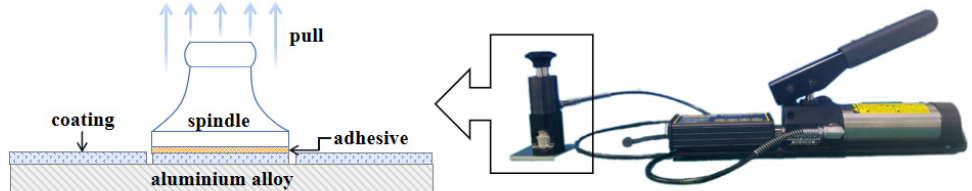
Figure 2. PosiTest AT-A coating adhesion test instrument and test principle.